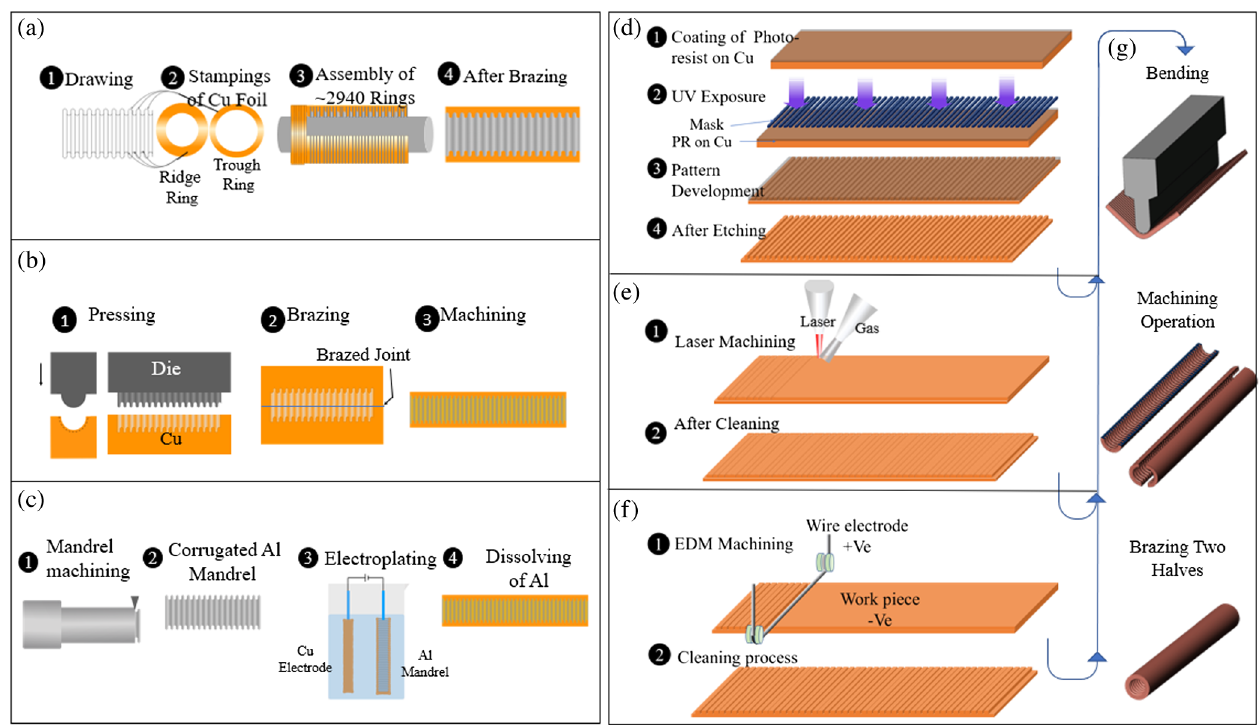
FIG. 2. Figures show various fabrication techniques that were investigated for production of the corrugated waveguide: (a) die stamping, (b) pressing, (c) electroforming, (d) optical lithography, (e) laser ablation, (f) electrical discharge